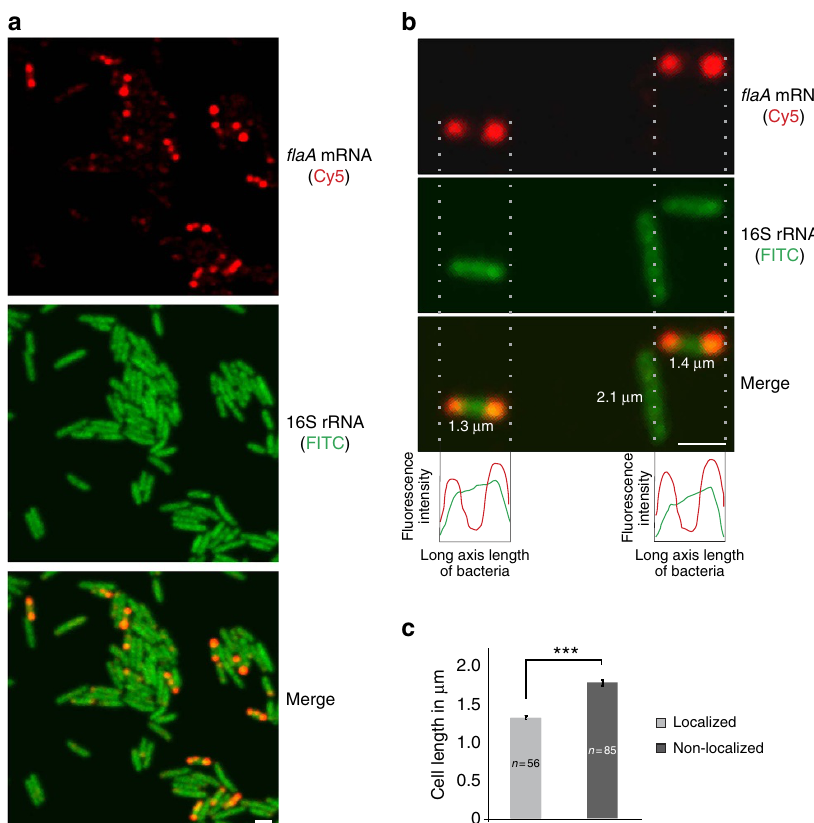
Figure 6 | flaA mRNA localizes to the poles of shorter cells. ( a ) RNA-FISH analysis of 16S rRNA (FITC-labelled DNA oligonucleotide probe, green) and flaA mRNA (14 Cy5-labelled single-stranded DNA oligonucleotide probes, red) in C. jejuni WTcells in mid-log phase using confocal microscopy (scale bar, 1 m m). ( b ) A magnified RNA-FISH image showing the distribution of fluorescence signals. flaA mRNA (Cy5) and 16S rRNA (FITC) signals were quantified along the long axis length of bacteria using ImageJ software and were subsequently merged as shown at the bottom of the panel (scale bar, 1 m m). The length of individual cells was also quantified using ImageJ. Statistical analysis for average flaA mRNA and 16S rRNA signals over the cell length is provided in Supplementary Fig. 15. ( c ) Average C. jejuni WTcell lengths in bacteria where flaA mRNA is localized (56 cells) or non-localized (85 cells), *** P o 10 (cid:3) 15 using Student’s t